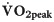
Bland-Altman plots showing 95% LoA for a) absolute V˙O2peak, b) relative V˙O2peak, c) HRpeak and d) POpeak. Mean difference between RAMP and PRETmax trials is indicated by solid black line with upper and lower limits indicated by dotted lines.